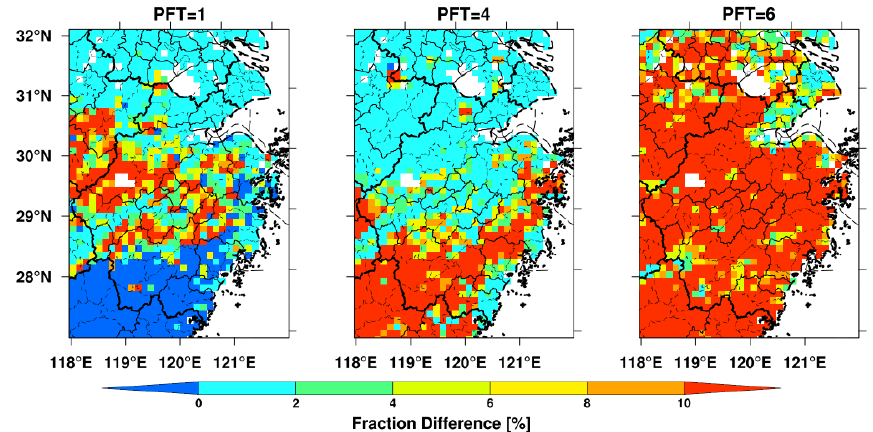
Figure 5. Spatial distribution of the PFT percentage difference between the VEG-2015 and VEG-USGS (VEG-2015 minus VEG-USGS) for needle-leaf evergreen trees (PFT = 1), broadleaf evergreen trees (PFT = 4) and broadleaf deciduous trees (PFT =